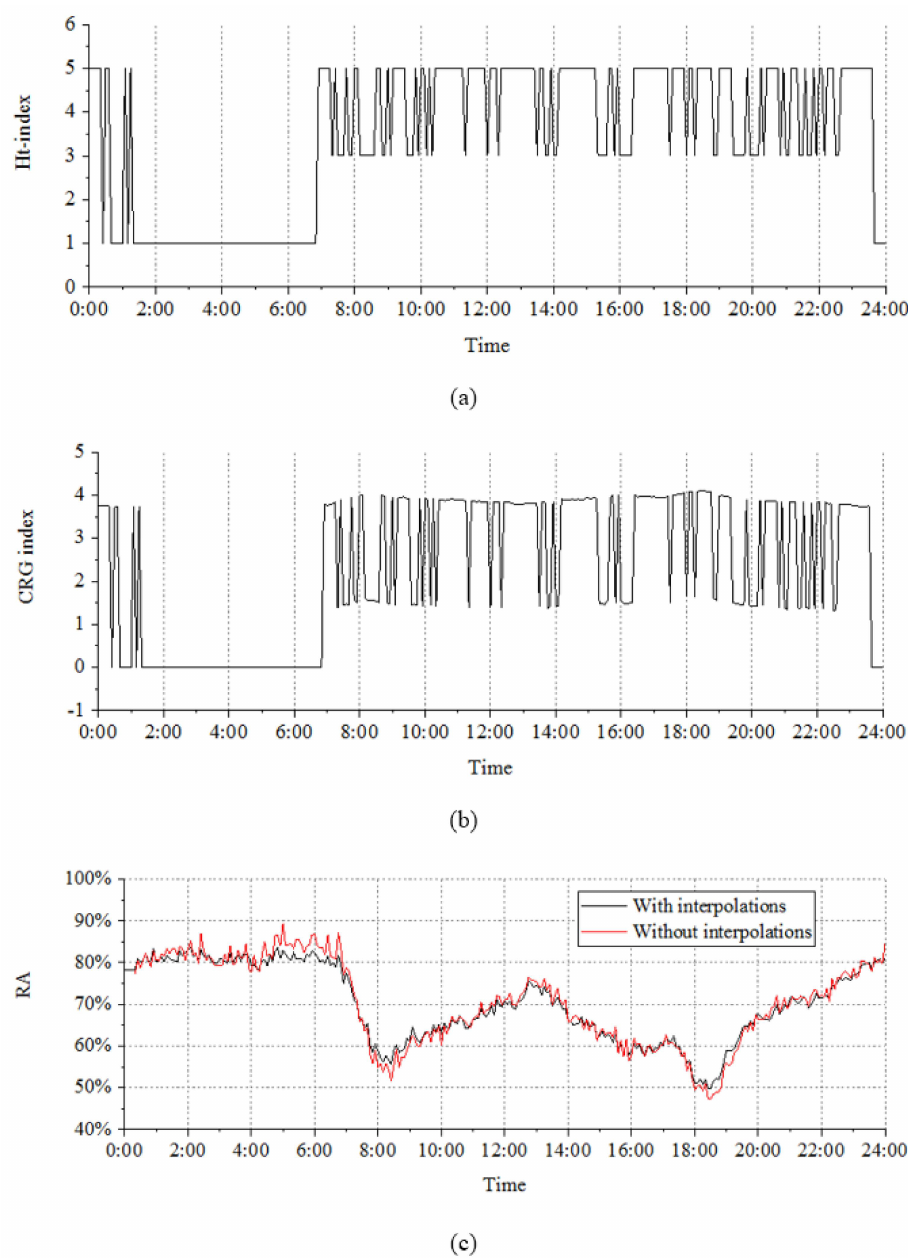
Figure 5. Traffic conditions of Shenzhen on 19 October 2015 (Monday) characterized by using ( a ) the ht-index; ( b ) the CRG index; and ( c ) the